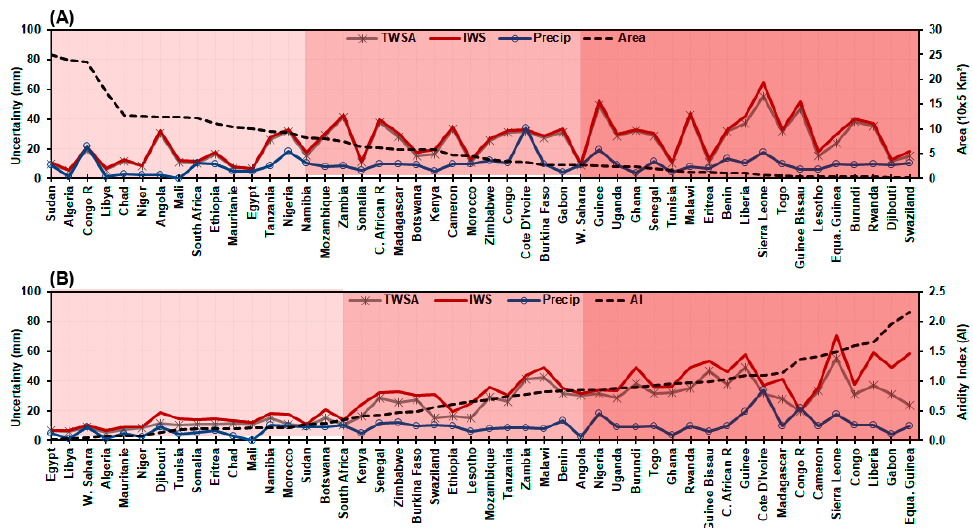
Figure 3. Uncertainty estimates of all variables calculated according to Equation (10) relative to countries area ( A ) and the aridity index ( B ). The aridity is calculated as the ratio of P / PET and classified following [54]. Areas of red shades indicate the average uncertainties for Total Water Storage Anomaly (TWSA) and Internal Water Storage (IWS) data.